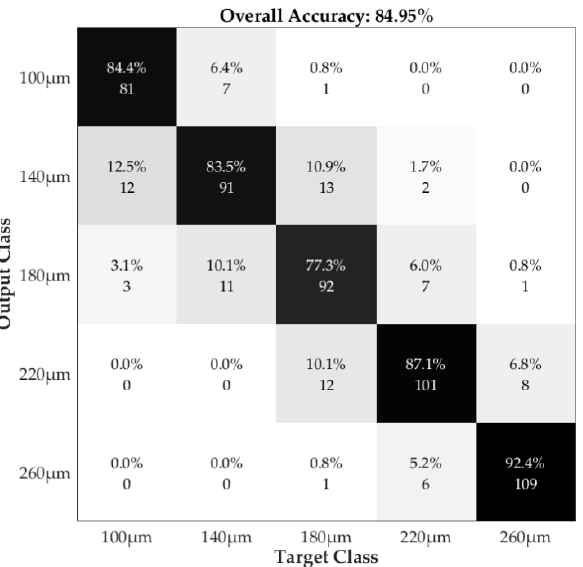
Figure 4. Confusion matrix of large scale crack detection using MSE-Faster R-CNN.